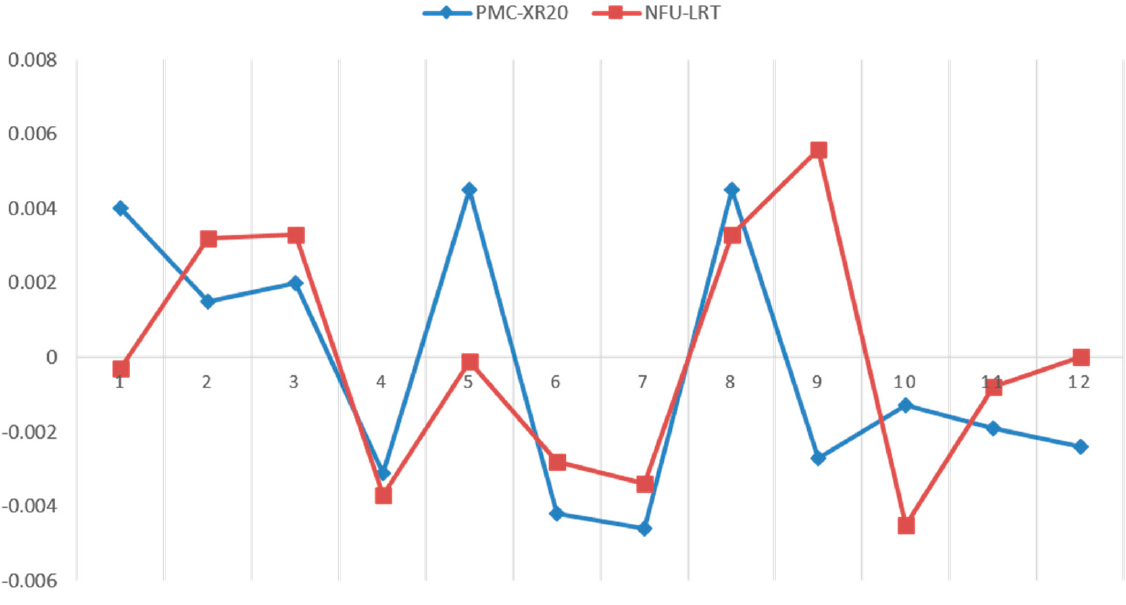
Table 2. System specification summary. Laser R-test